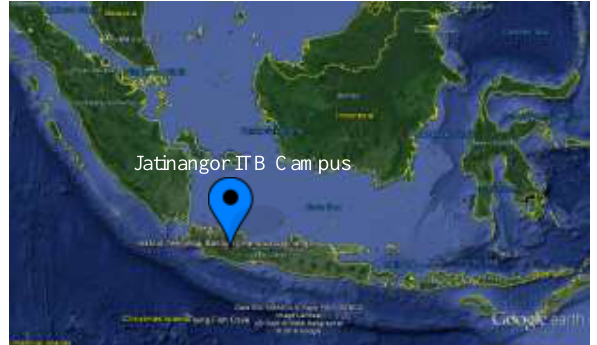
Figure 1. Jatinangor ITB Campus location